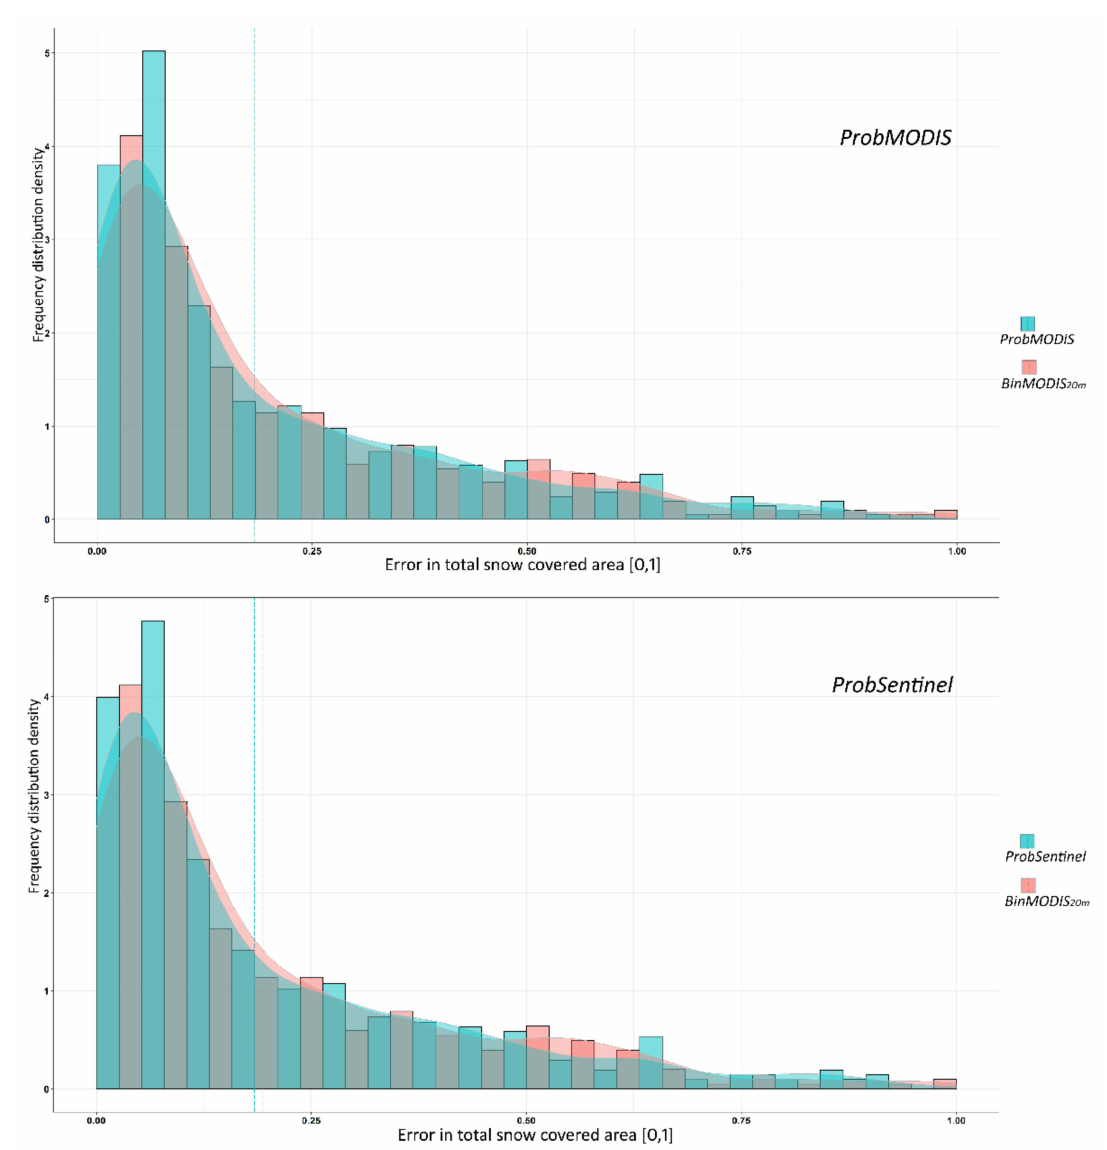
Figure 9. Frequency distribution of the absolute error in total snow-covered area estimation obtained for ProbMODIS (upper panel) and ProbSentinel (bottom panel) when compared to the snow-covered area retrieved with Sentinel-2. The two graphs also depict the BinMODIS 20m frequency distribution. Vertical dashed lines show the corresponding mean snow-covered area error during the study period. These graphs include the results for the three